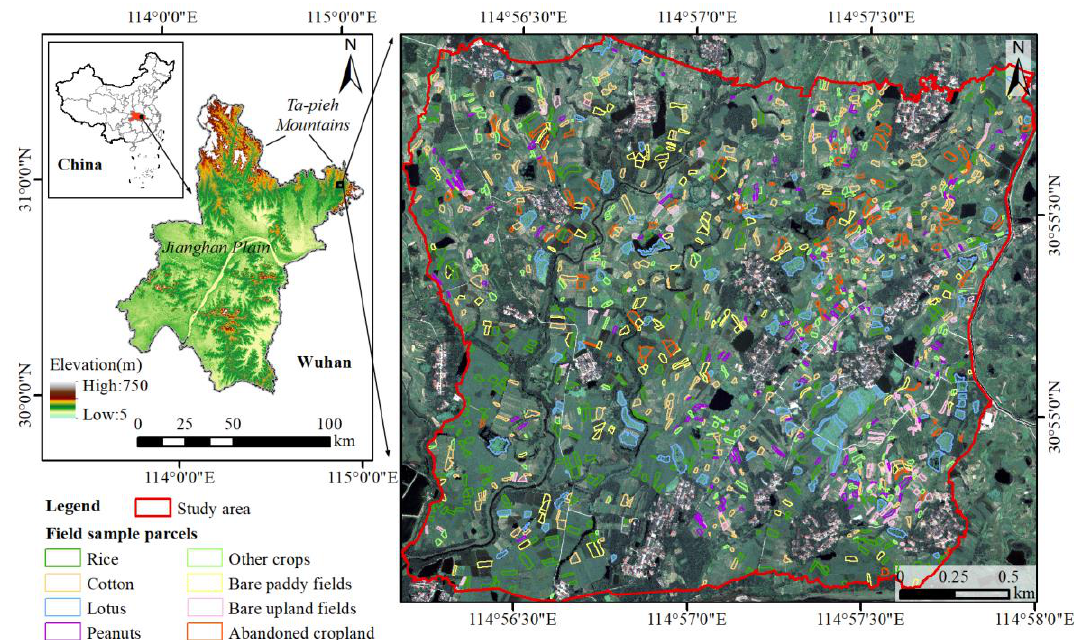
Figure 1. Location of the study site ( left ) and the distribution of sample parcels based on the true-color WV2 image ( right ). Considering the completeness of the parcel boundary, the area within the red line was used for subsequent analysis.